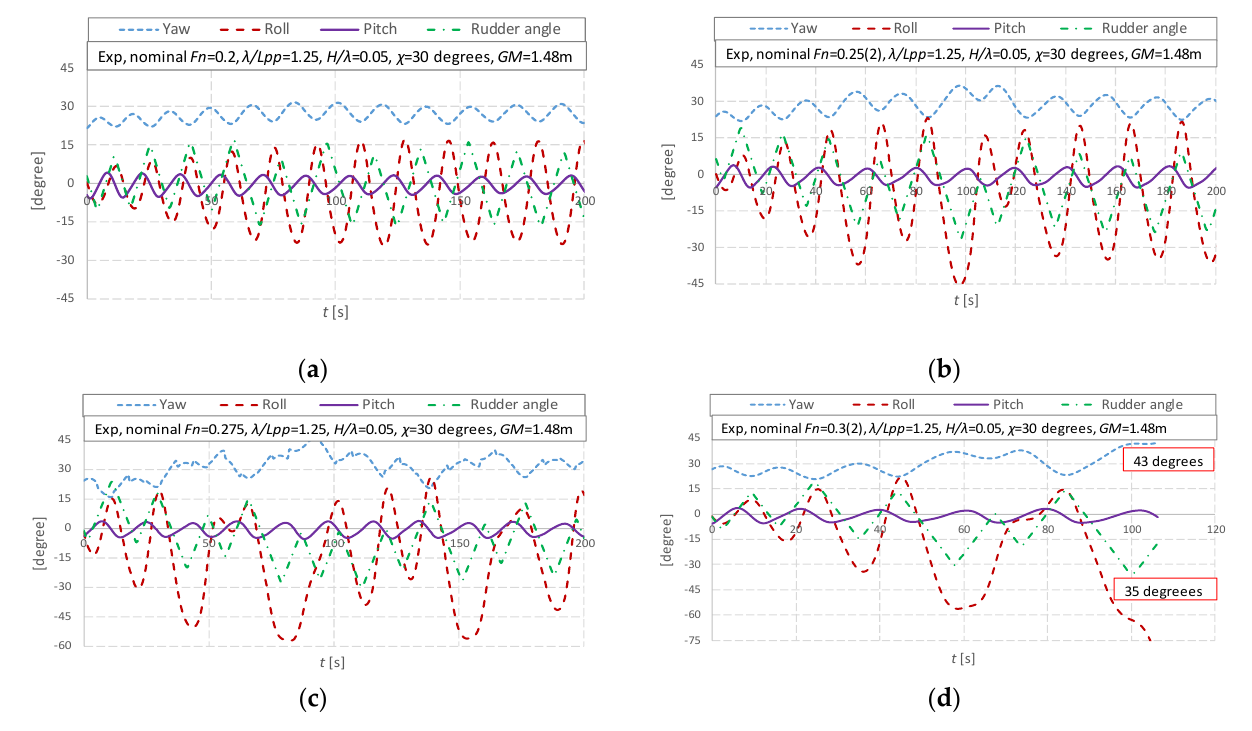
Figure 11. The time-domain rolling, pitching, yawing motions, and rudder angle in the tests, ( a ) Fn = 0.2, stable roll motion; ( b ) Fn = 0.25, unstable roll motion; ( c ) Fn = 0.275, subharmonic roll; ( d ) Fn = 0.3,